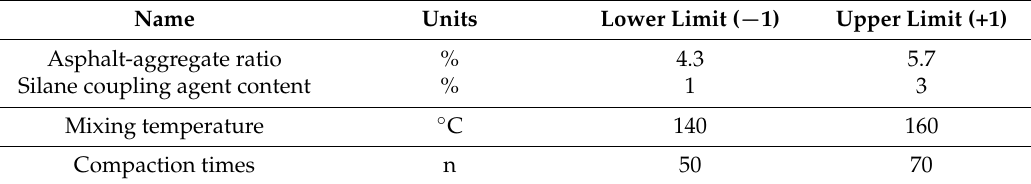
Table 4. The coded level of affected variable.